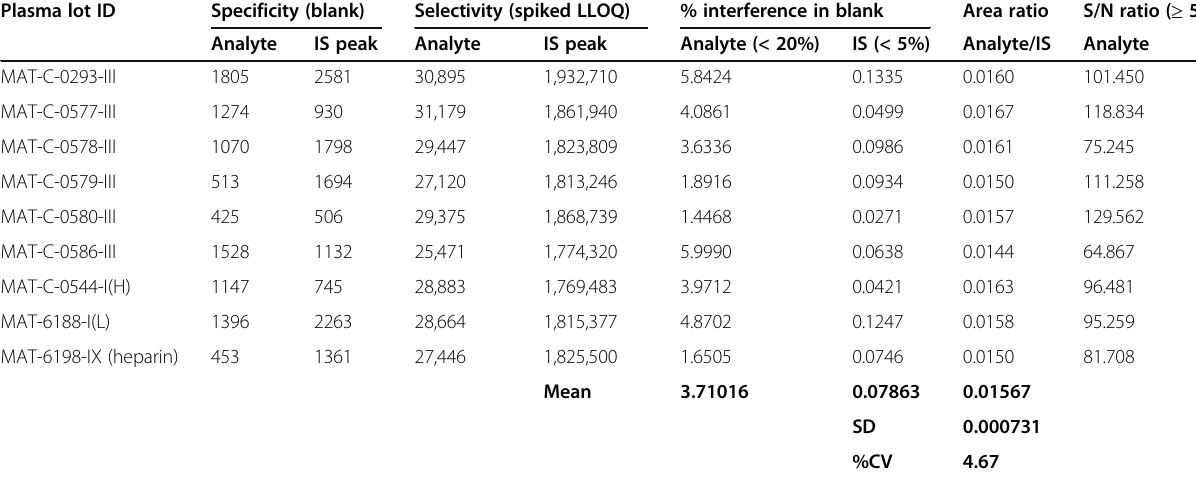
Table 1 Specificity and selectivity for bexarotene and internal standard (MTR-BA-LC-MS/MS-05) Plasma lot